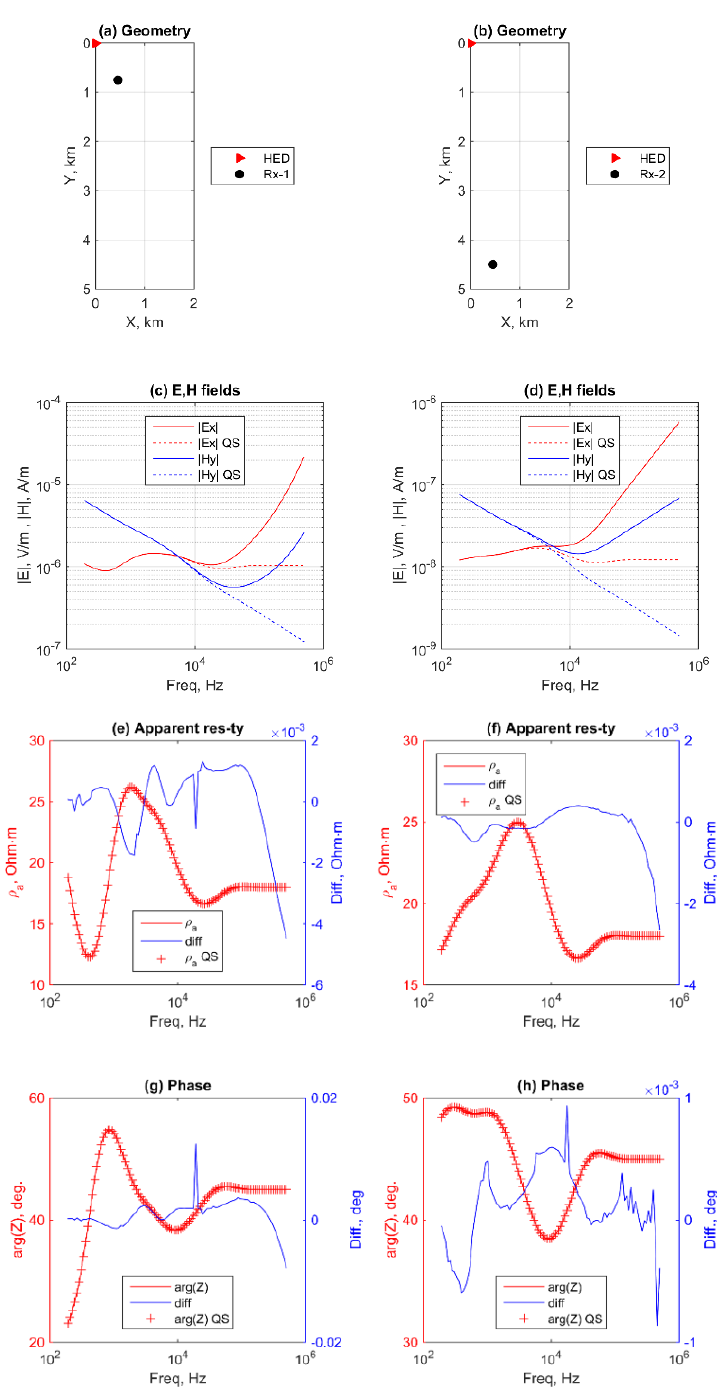
Figure 2. Impact of the displacement currents on the electromagnetic field and the surface impedance on the top of a layered Earth. The left column of panels illustrates computations relative to a short transmitter–receiver separation (receiver Rx-1). The right column of panels presents computations for a long transmitter–receiver separation (receiver Rx-2). Panels ( a , b ) depict geometry of the simulation, the top view. An X-oriented horizontal electric dipole (HED) was placed at the origin. Receiver station Rx-1 was located at (450, 750) m, whereas receiver station Rx-2 had coordinates (450, 4500) m. Panels ( c , d ) depict magnitudes of individual components of the electric field. Panels ( e , f ) depict Cagniard’s apparent resistivity ( ρ a ). Panels ( g , h ) show impedance phase. In the legends, QS stands for the quasi-stationary computations.